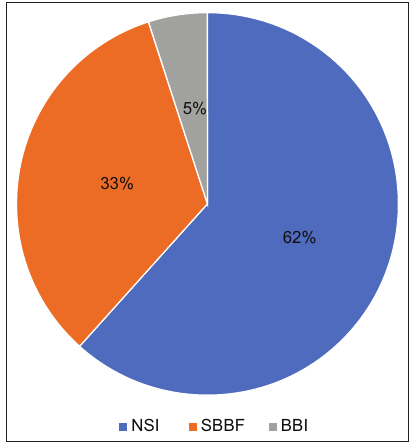
Figure 3 : Compliance with Post-Exposure Prophylaxis as Per Injury